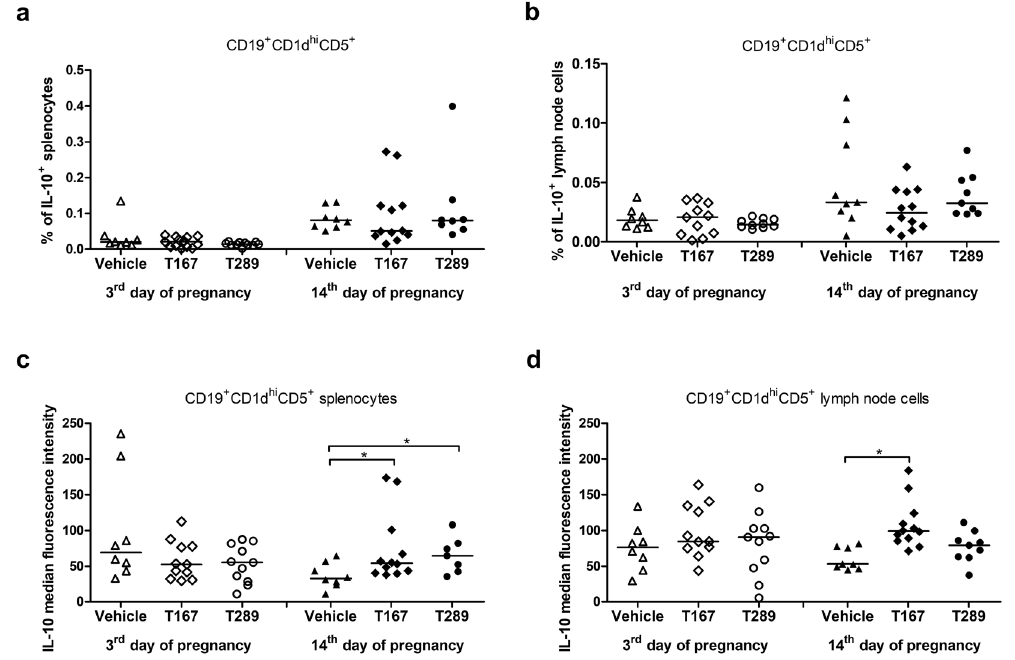
Figure 4. Effect of tregitope treatment on regulatory B lymphocytes in a murine abortion-prone pregnancy model. Cells were stimulated with PMA and ionomycin in the presence of brefeldin A and monensin and the frequencies of CD19 + CD1d + CD5 + IL-10 + ( a) splenocytes and (b) uterine-draining lymph node cells, and the production of IL-10 by CD19 + CD1d + CD5 + ( c) splenocytes and (d) lymph node cells were analysed by intracellular staining. The data were analysed by one-way ANOVA (normal distribution) or the Kruskal-Wallis test (non-normal distribution) with Dunn’s multiple comparison post hoc test (P < 0.05) and are presented as individual values with median (at 14dpc n = 12 for T167, n = 9 for T289, n = 9 for Vehicle; at 3dpc n = 11 for T167, n = 11 for T289, n = 9 for Vehicle). * P < 0.05, ** P < 0.01, and *** P <